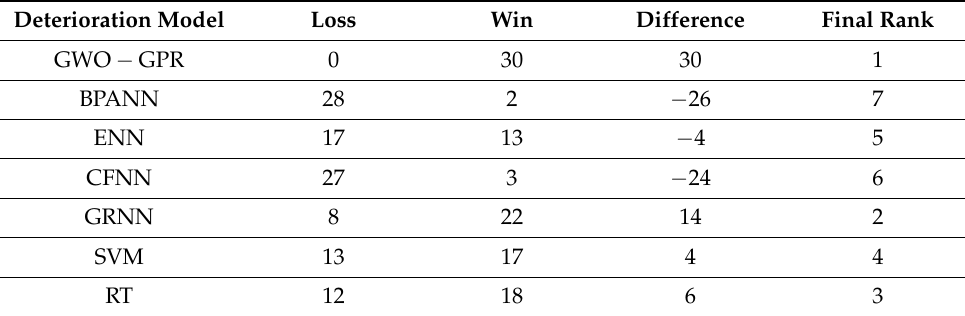
Table 11. Final rankings of the Copeland